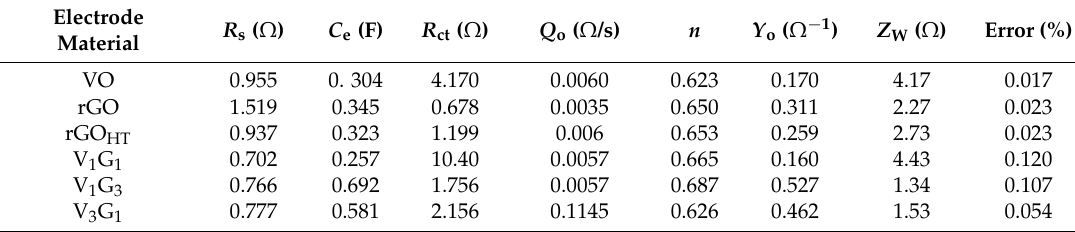
Table 3. Summary of ac impedance spectroscopy data simulations with CPE circuit element parameters.